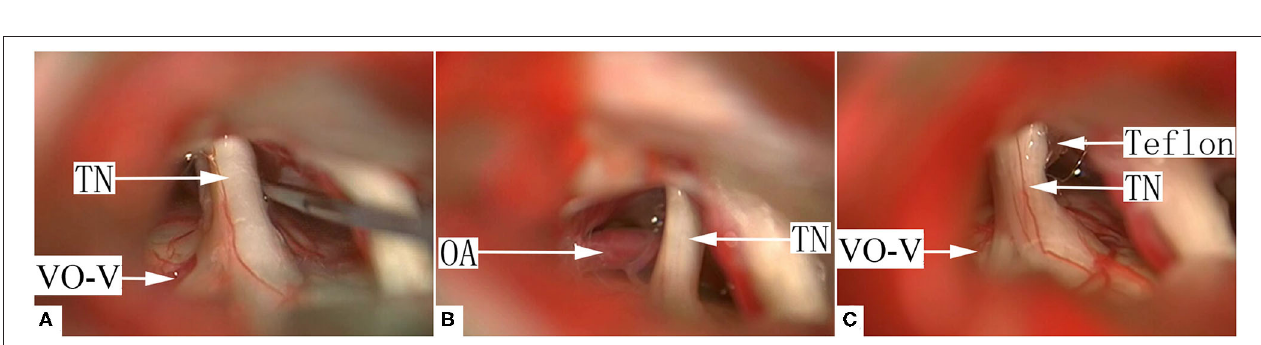
FIGURE 4 | A representative case of typical group II, type B VO-VREZ. (A) The VO-VREZ was lateral to the nerve root and a suspected offending artery was found. (B) Decompression of the offending artery with shredded Teflon interposition. (C) Dissection and decompression of VO-VREZ with shredded Teflon interposition.TN, trigeminal nerve; VO-V, venous offending on the ventral side of root entrance/exit zone; OA, offending artery.